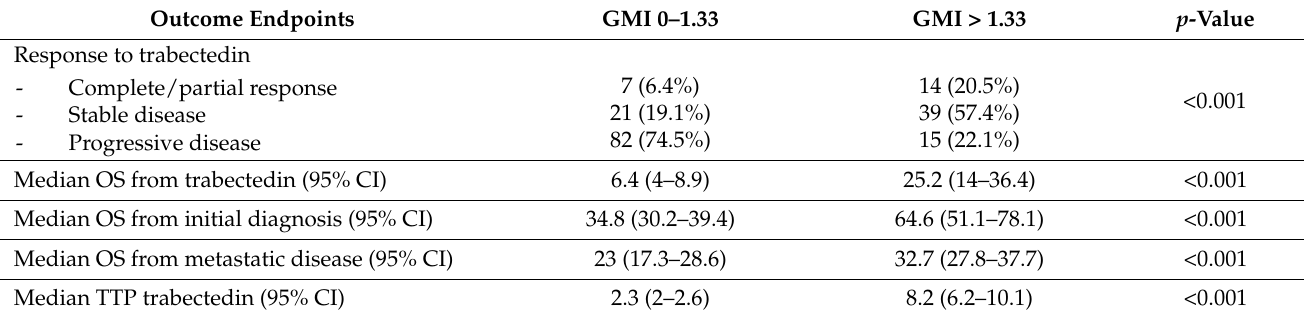
Table 3. Relation between the GMI and other activity end-points in the training